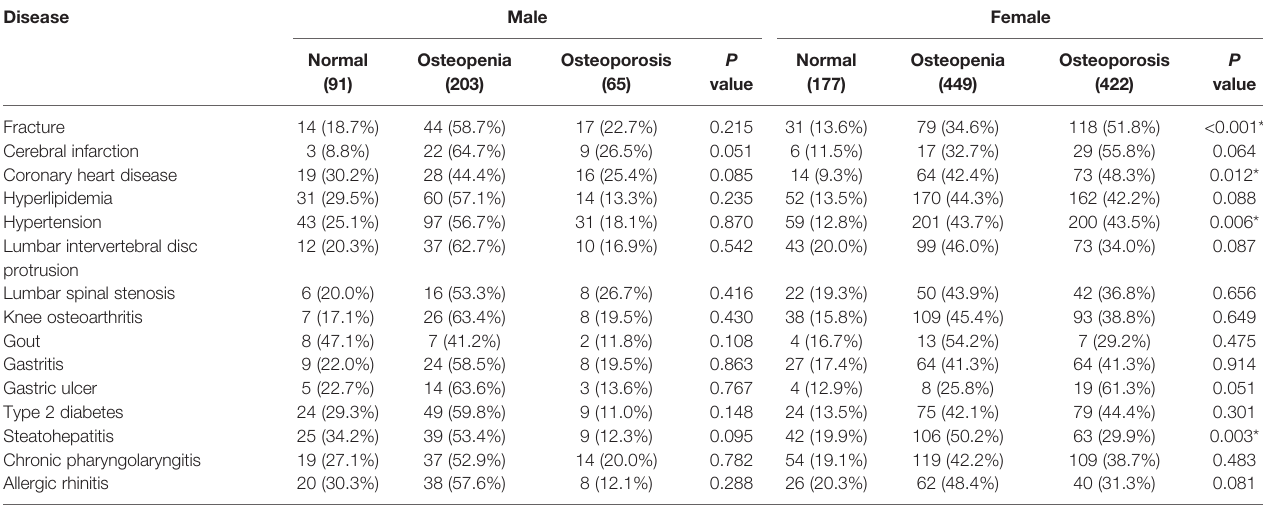
TABLE 3 | Medical history of study participants. Disease